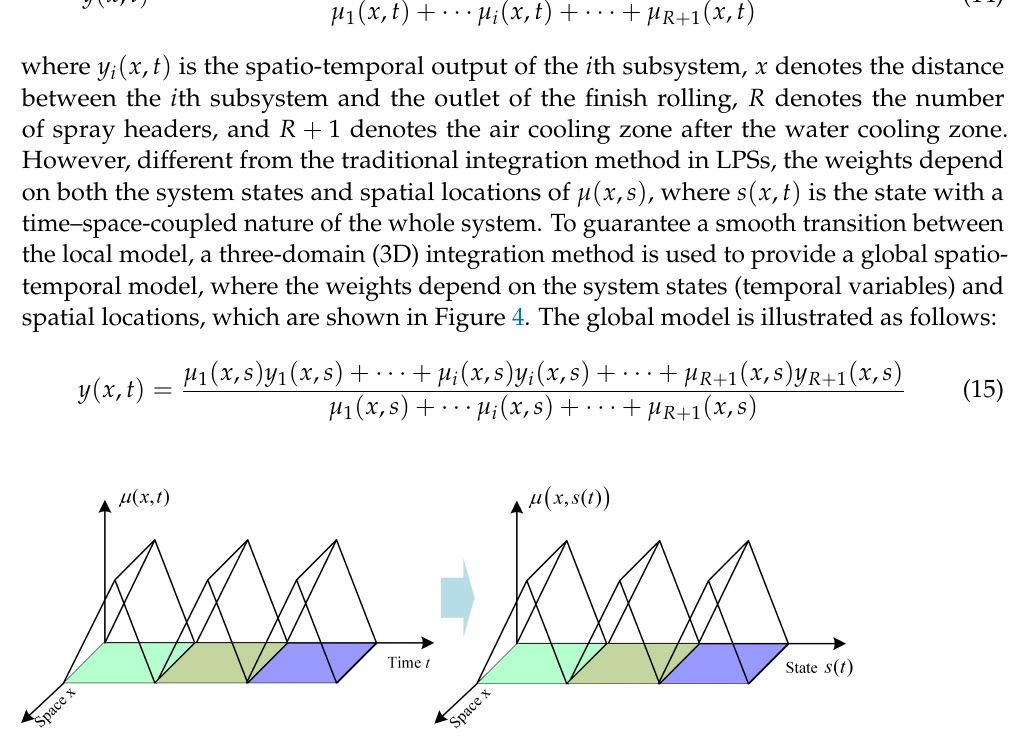
Figure 4. Three-domain membership